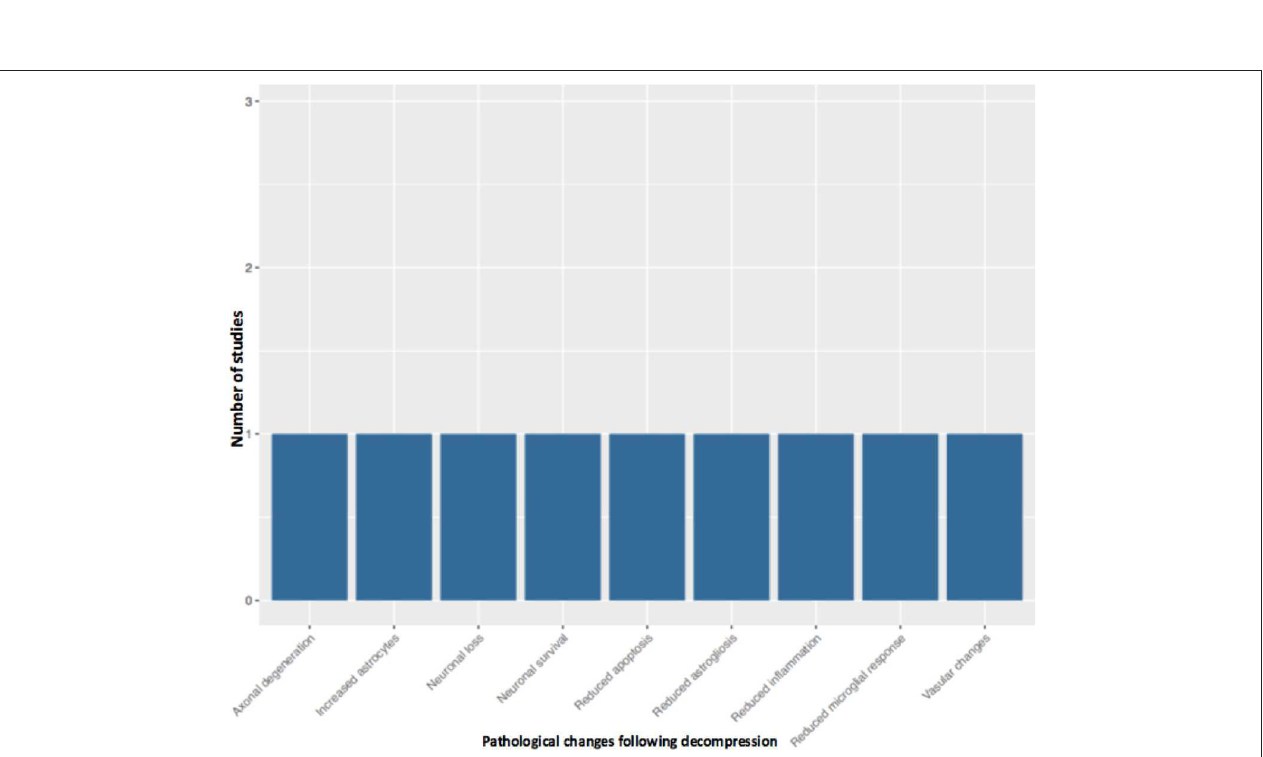
FIGURE 3 | Pathological changes in the decompressed spinal